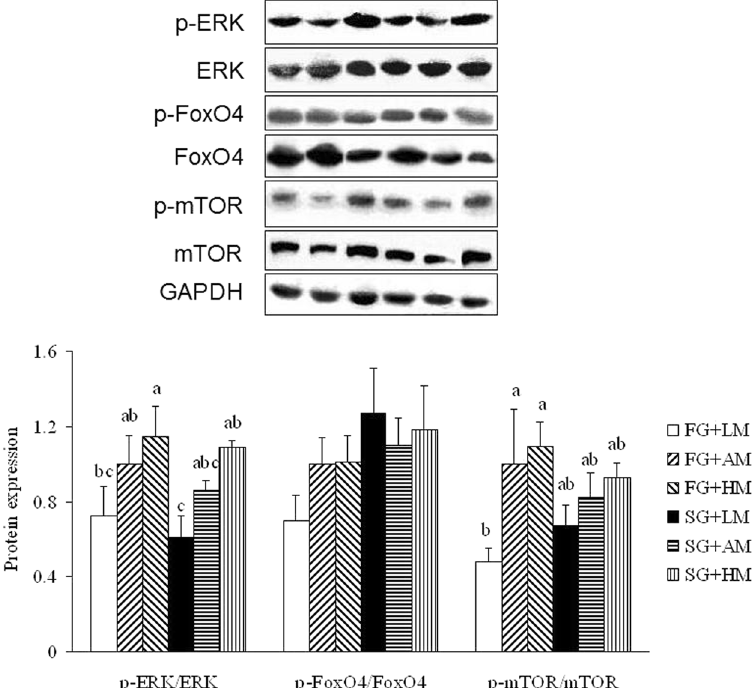
Figure 1. Effects of dietary methionine on protein expression in breast muscle of broilers at 42 d of age. Results are presented as means ± SEM (n = 6). Bars marked with different letters are significantly different at P < 0.05. Full-length blots are shown in Supplementary Figure